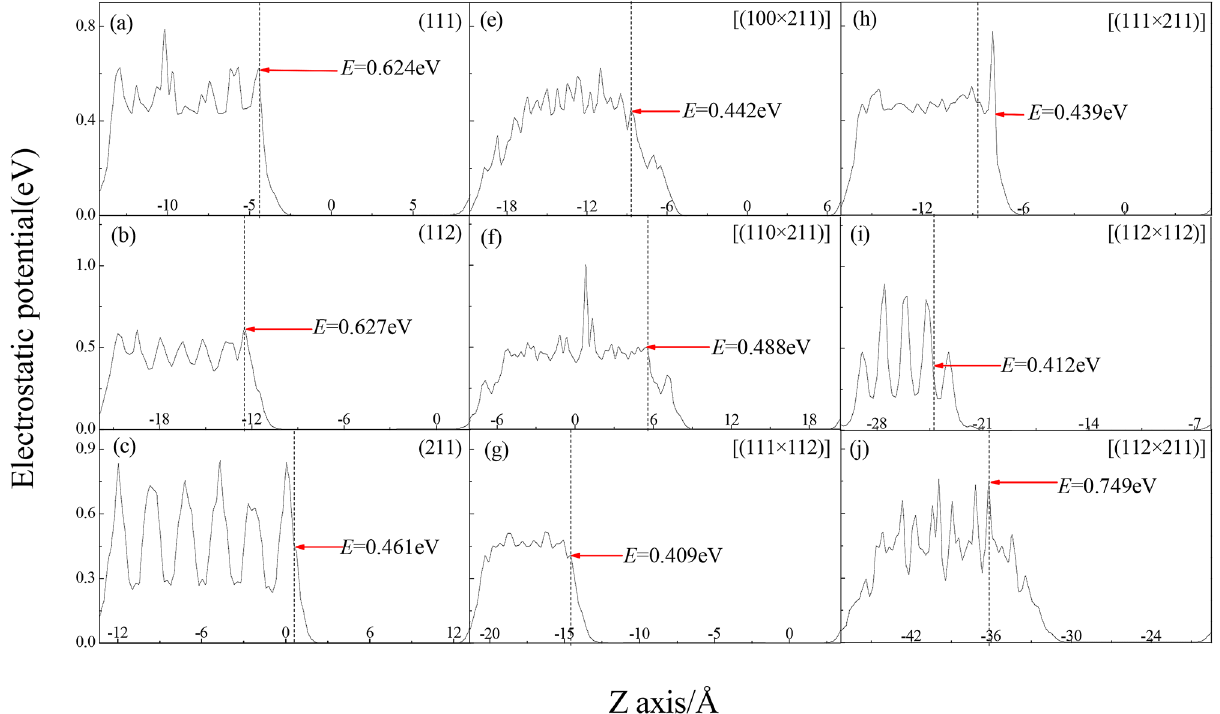
Figure 7. Electrostatic potential of MnO 2 bulk surface and microfacet